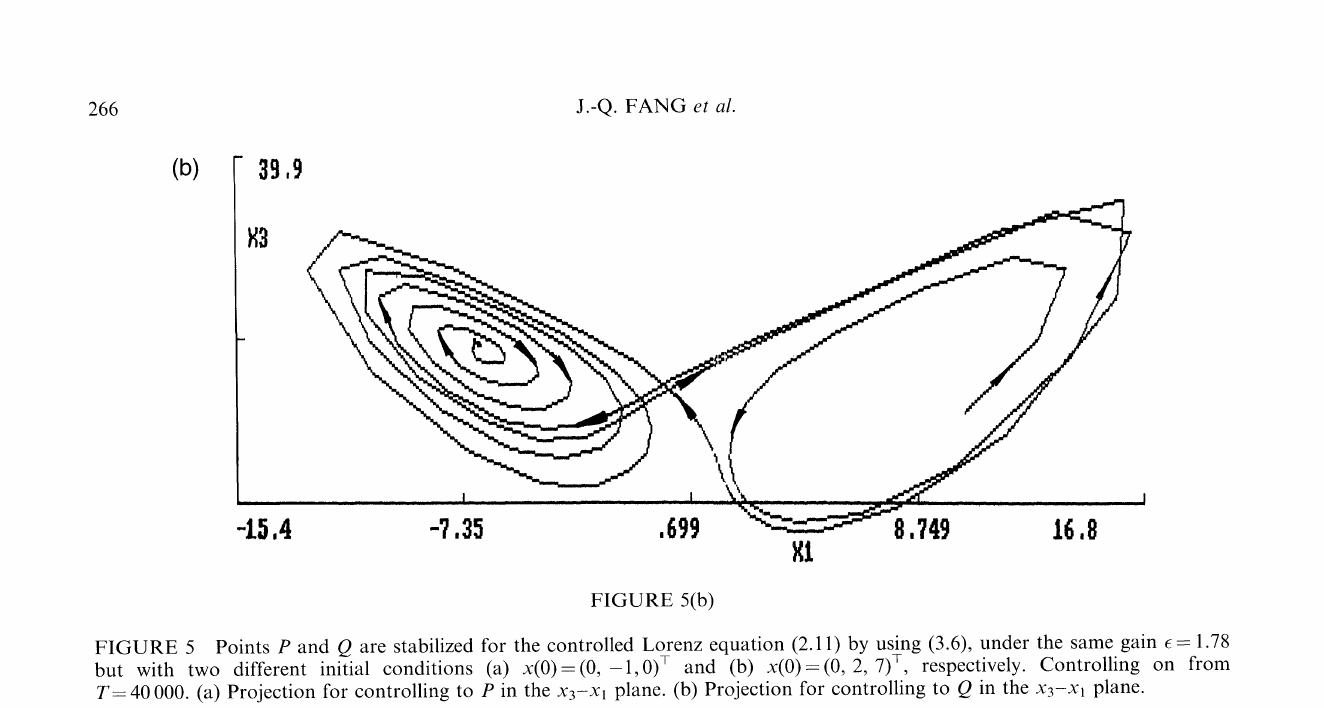
-c, respectively. Controlling on from